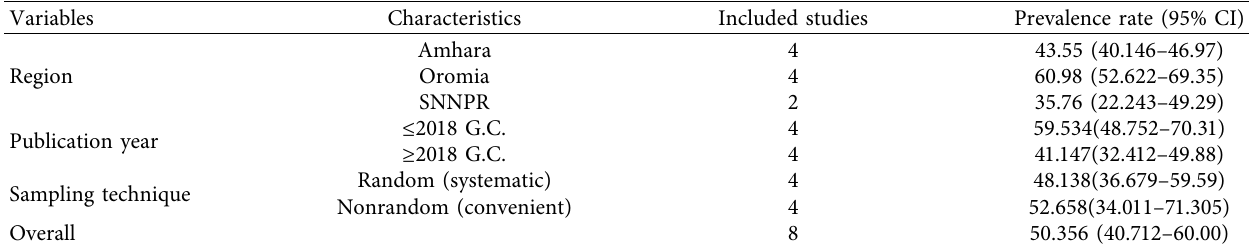
Table 2: Subgroup analysis result of the